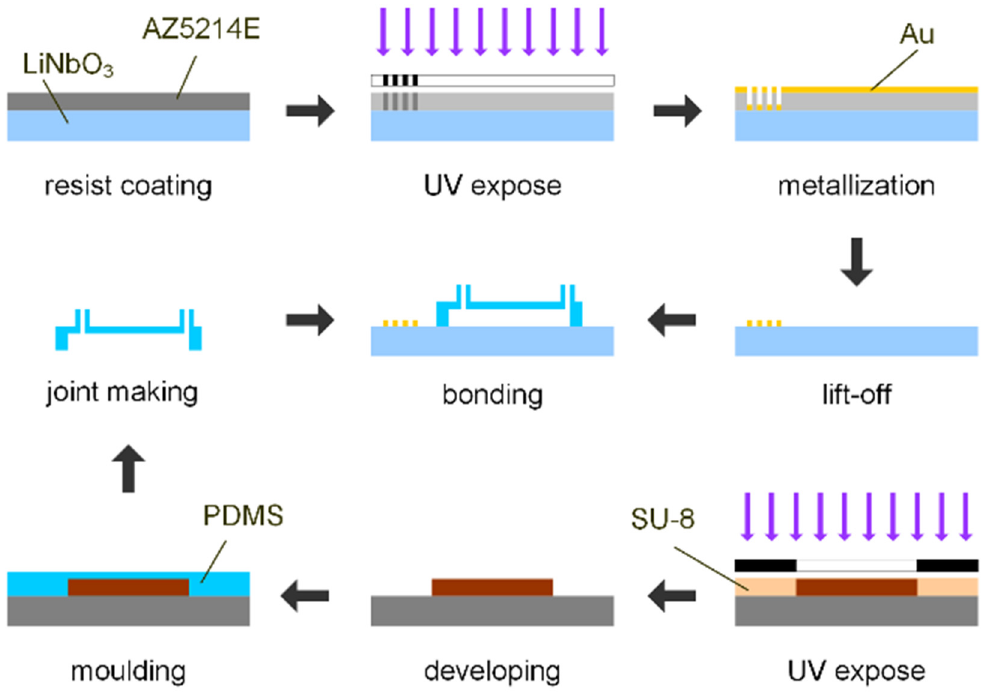
Figure 2. Fabrication process of the SSAW mixing device.